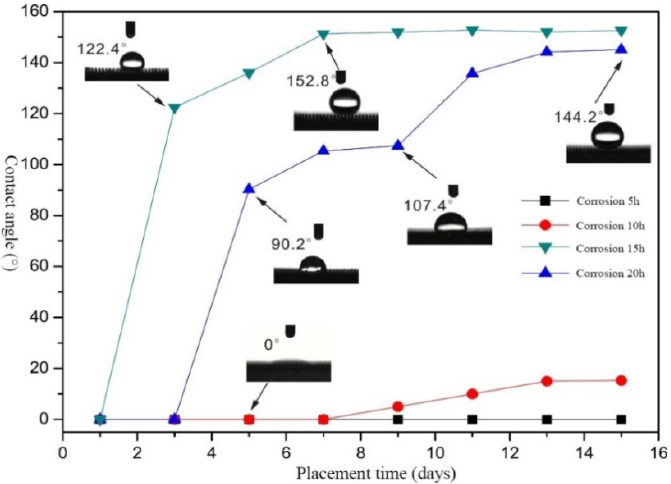
Figure 2. The change curve of the contact angle of 3D-printed + corroded samples with